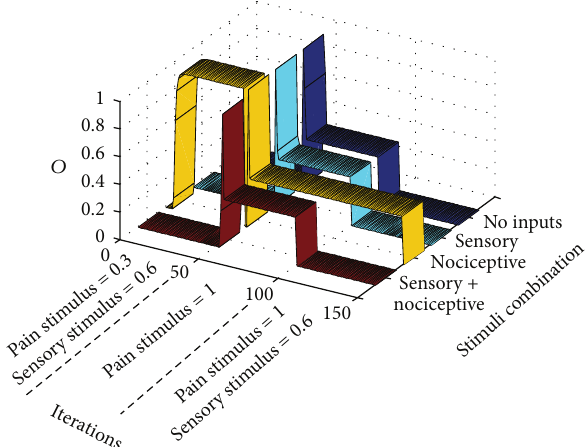
Figure10:Modelingwind-downpain:after50iterationsofstandard training epochs, signals from nociceptive receptors become very intense. From iterations 50 to 100, the gate circuit, instead of receiving different stimuli like in previous cases, receives an intense nociceptive stimulus of value 1. For testing pain responses to other types of stimuli during the phase of intense nociceptive stimulation, all types of plasticity (synaptic and intrinsic) are blocked from iterations 100 to 150 (this procedure was not done in previous examples). As seen, after a long intense pain stimulation, the circuit becomes less responsive to all types of stimuli.